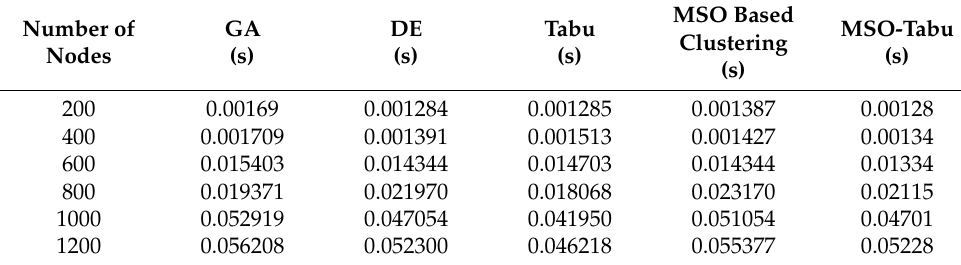
Table 3. Average end-to-end delay for MSO-Tabu.